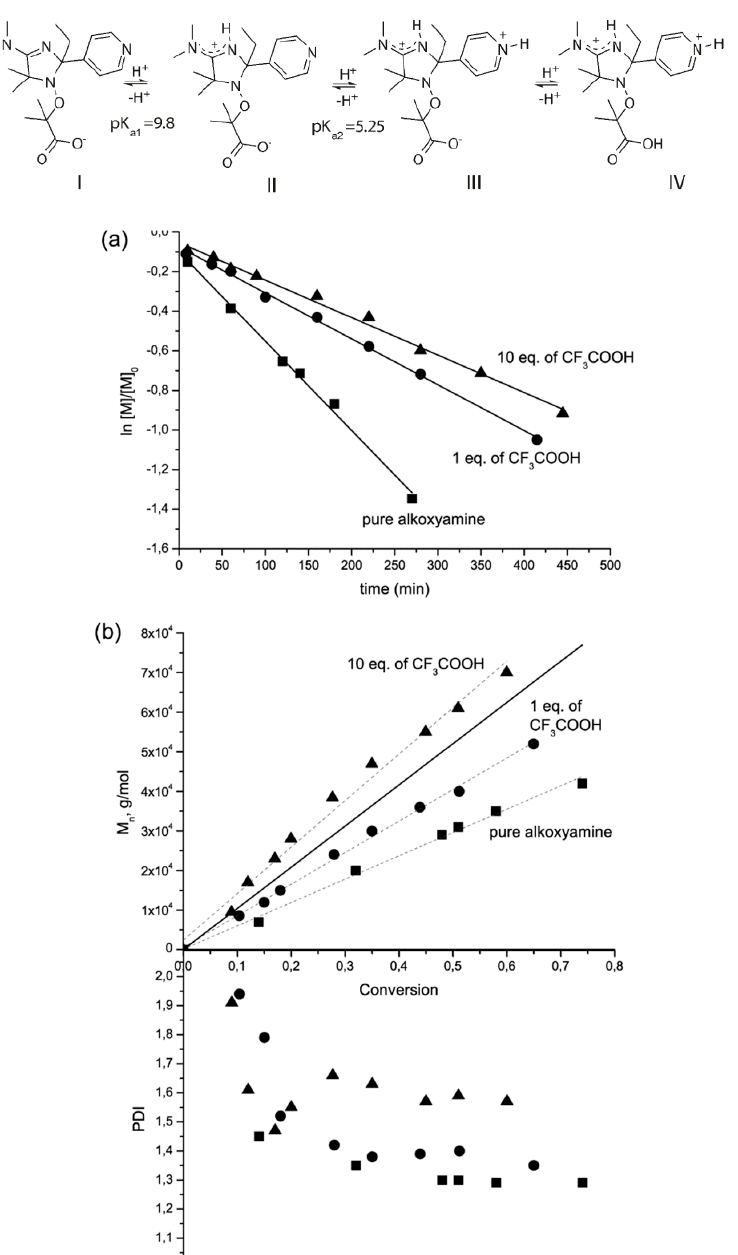
Figure 8. Protonated forms of alkoxyamine 10. Polymerization of styrene at 140 °C initiated by protonated or deprotonated forms of alkoxyamine 10 . The monomer-to-initiator ratio is 1000/1. ( a ) A kinetics plot for polymerization; lines: a linear fit of the experimental data points; ( b ) Evolution of molecular weight and dispersity. ■ : pure alkoxyamine, form II; ● : alkoxyamine in the presence of 1 eq. of CF 3 COOH, form III; ▲ : alkoxyamine in the presence of 10 eq. of CF 3 COOH, form IV. The solid line denotes the theoretical M n , dashed lines: a linear fit of the experimental data points. Adapted with permission from Ref. [30] . Copyright 2011 American Chemical Society.